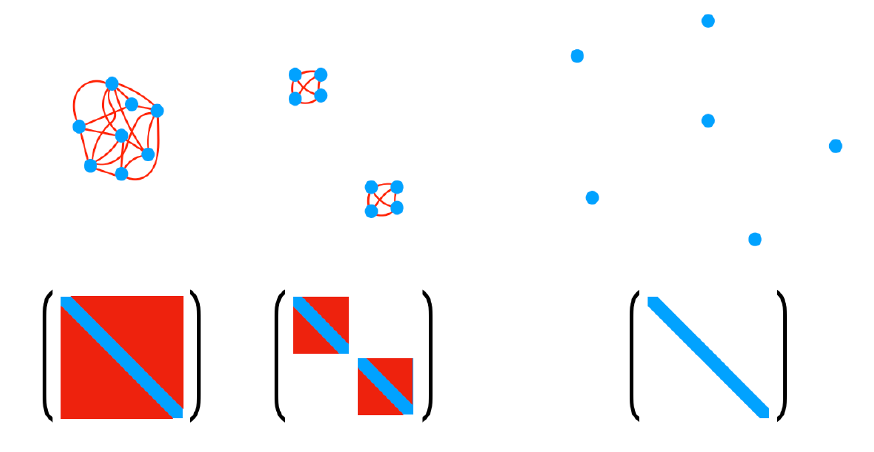
Figure 2 . Matrix con(cid:12)gurations for one big black hole (left), two black holes (middle) and the gas of D0-branes